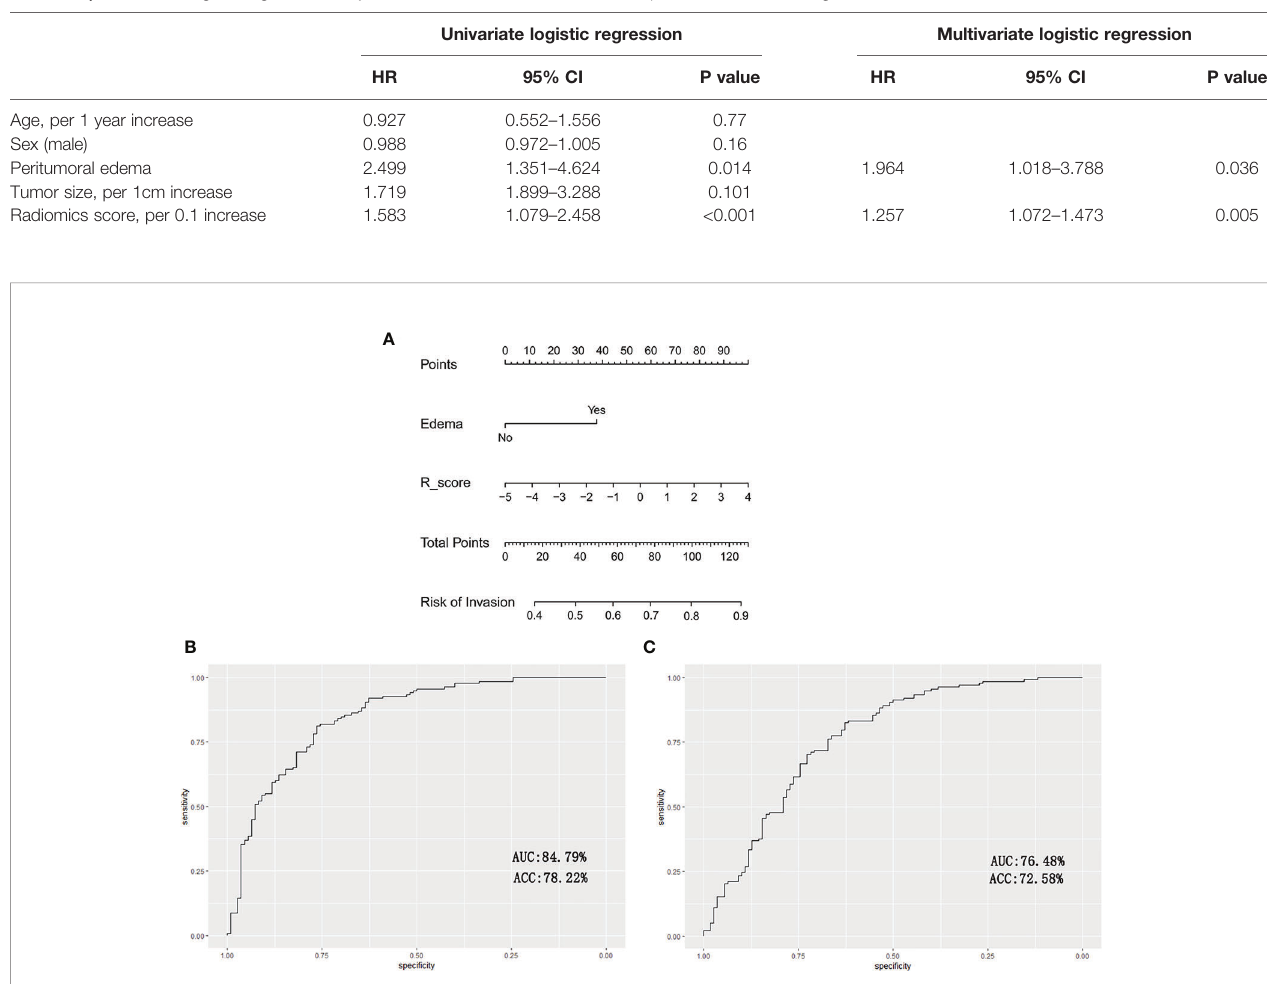
TABLE 3 | Multivariate logistic regression analysis of the radiomics score and clinical predictors in the training set.